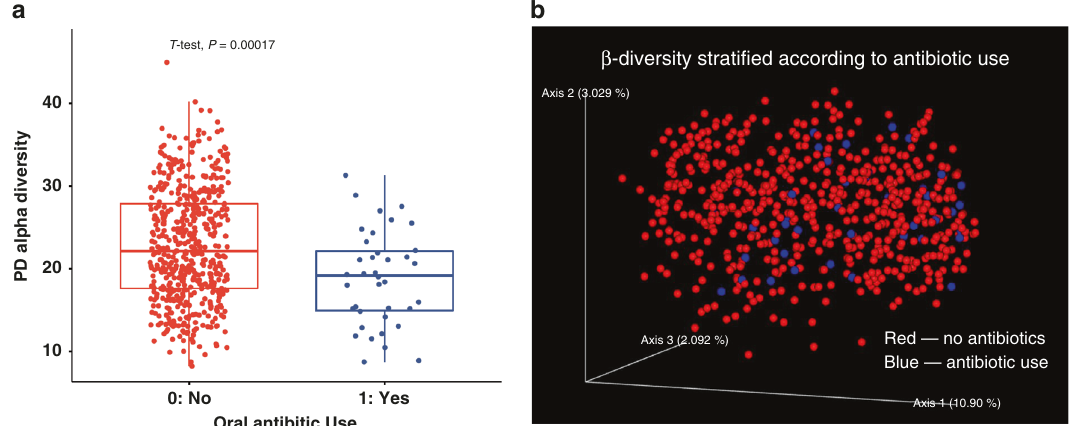
Fig. 4 Antibiotic use correlates with reduced α -diversity and de fi nes signi fi cant β -diversity clusters. a Reduced α -diversity in patients who have taken antibiotics within in the last 30 days (box plots indicate median (middle line), 25th, 75th percentile (box) and each single dot represents a sample, with sample size n = 528 for subjects with no oral antibiotic use and n = 38 for subjects with oral antibiotic use; p -value obtained from two-sided t -test). b Unweighted UniFrac PCoA plot showing signi fi cant difference in β -diversity associated with antibiotic use ( q -value = 0.006 from PERMANOVA test after BH-FDR correction). Source data are provided as Source data fi le: “ sourcedata_ fi g4a.txt and sourcedata_ fi g4b_ fi g5.txt ” .